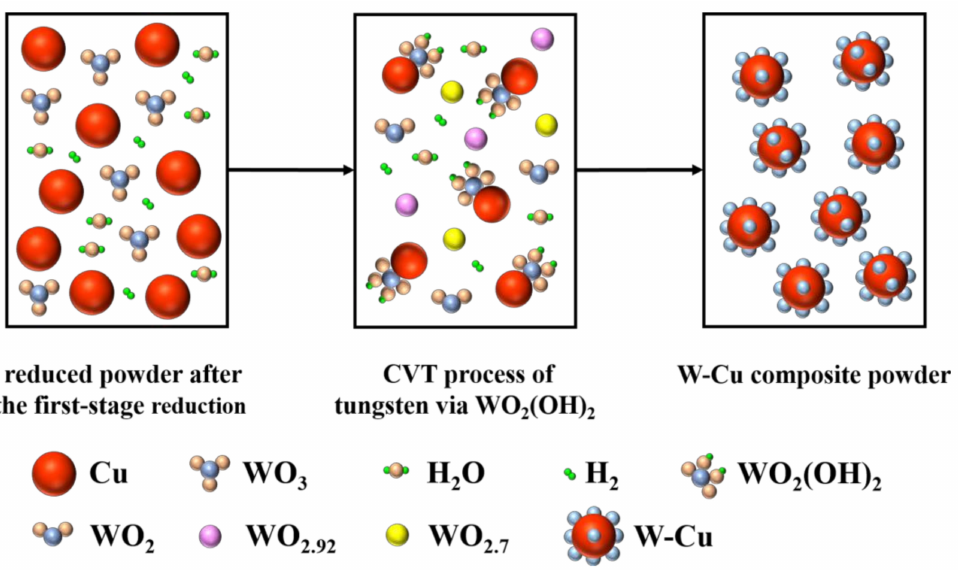
Figure 17. Phase evolution in the reduction in WO 3 . When the content of W is 30 wt%, the D50 of reduction powder reaches the lowest value, and the D 10 , D 50 , and D 75 values of reduced powder are the closest. Therefore, the growth of Cu particles can be effectively inhibited, and the uniformity of powder size can also be promoted by adding W particles [35]. The histogram of the particle size distribution of reduction powders with different W content is presented in Figure 18f; the difference between D(3, 2), D(4, 3), and D50 of Cu-30 wt%W composite powder is the least. Therefore, Cu-30 wt%W composite powder has regular morphology and uniform